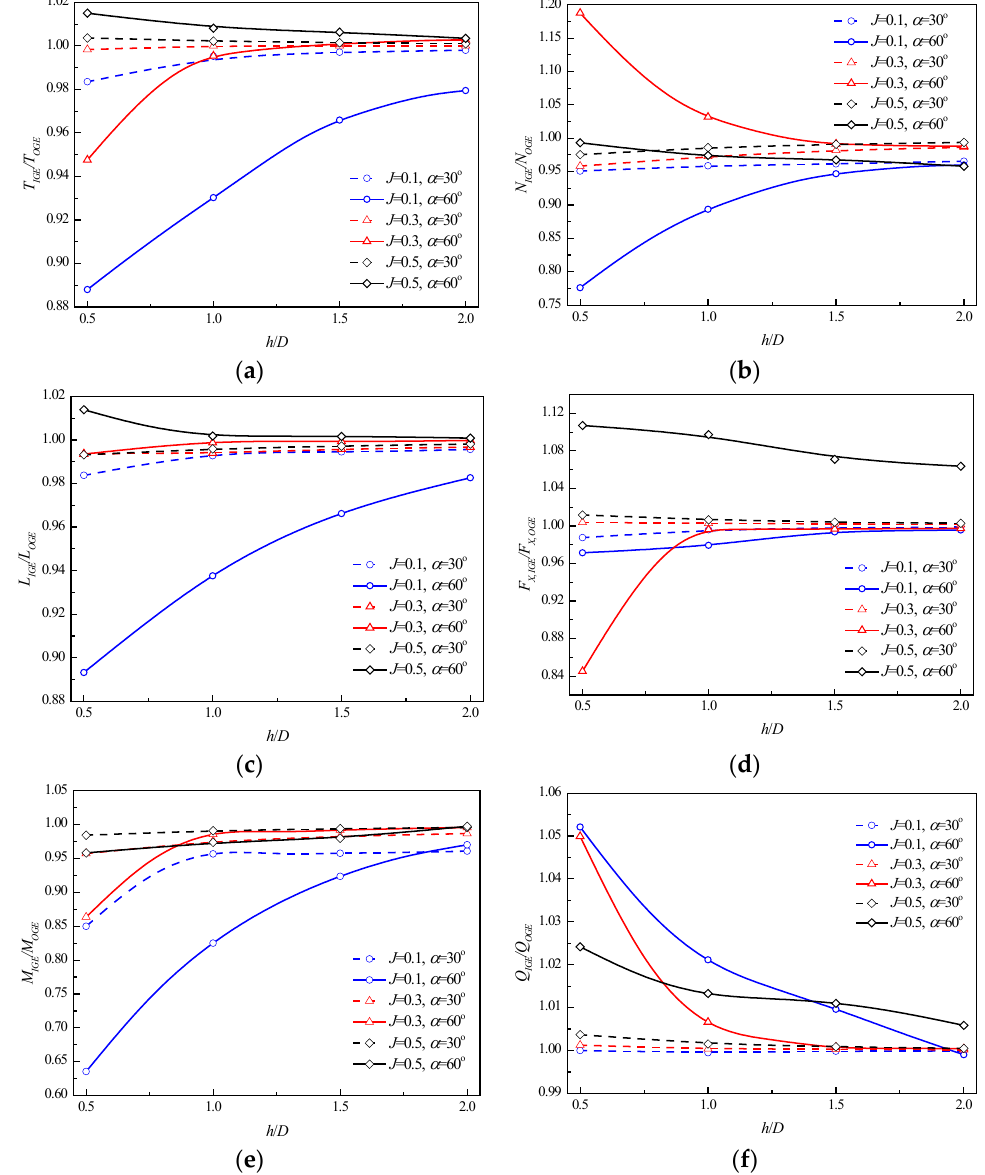
Figure 22. Load ratios at different heights, advance ratios, and angles of attack : ( a ) thrust ratio; ( b ) normal force ratio; ( c ) lift ratio; ( d ) propulsive force ratio; ( e ) duct pitching moment ratio; ( f ) torque ratio.